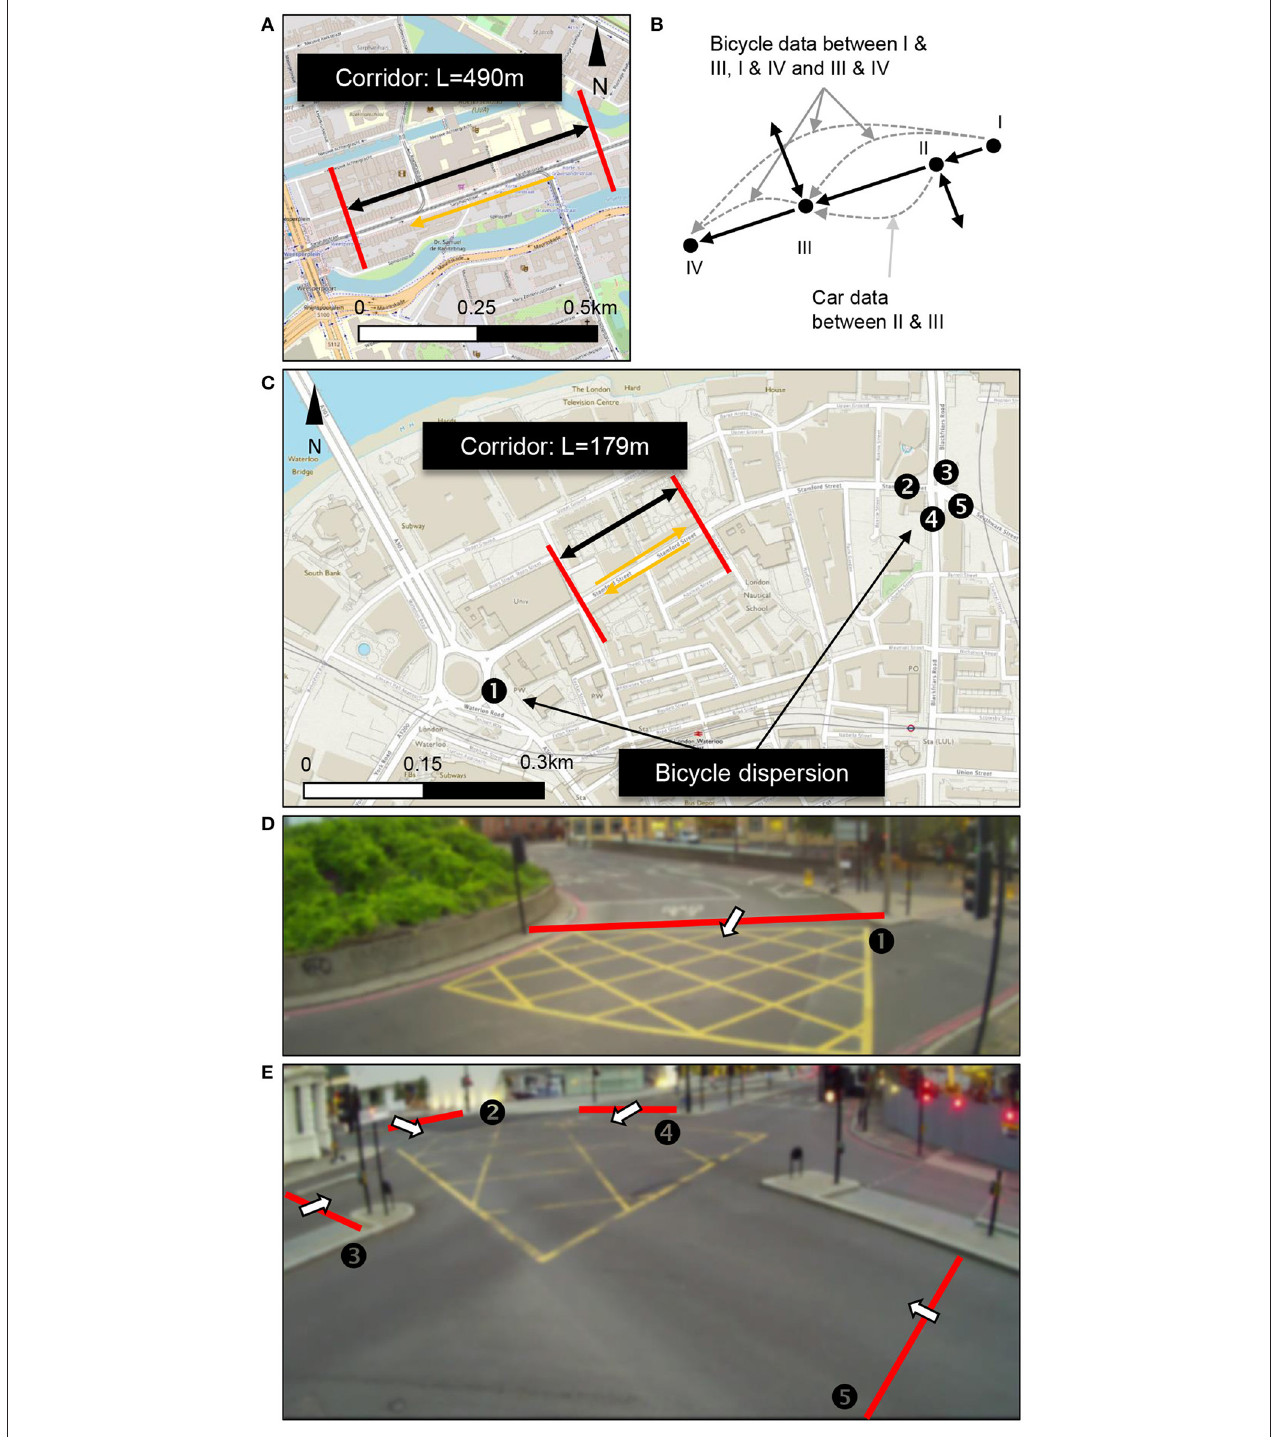
FIGURE 2 | Experimental sites for the measurements of bicycle interactions. (A) Travel time corridor along Sarphatistraat in Amsterdam. Background map courtesy of https://www.openstreetmap.org/. (B) Locations between which travel times of cars and bicycles were recorded. There are several locations to account for in and outflow from site streets. The measurements used for the calibration are between locations II and III. (C) Measurement locations for the calibration of the bicycle interaction models along Stamford Street in London. Background map courtesy of https://osmaps.ordnancesurvey.co.uk/. (D,E) Show original footage from the installed cameras of the two sites in London to illustrate the layout of the bicycle stopping boxes. Box number 1 is shown in (D) and boxes 2–5 are shown in (E) . All cameras are covered for blurring images to protect travelers’ privacy.